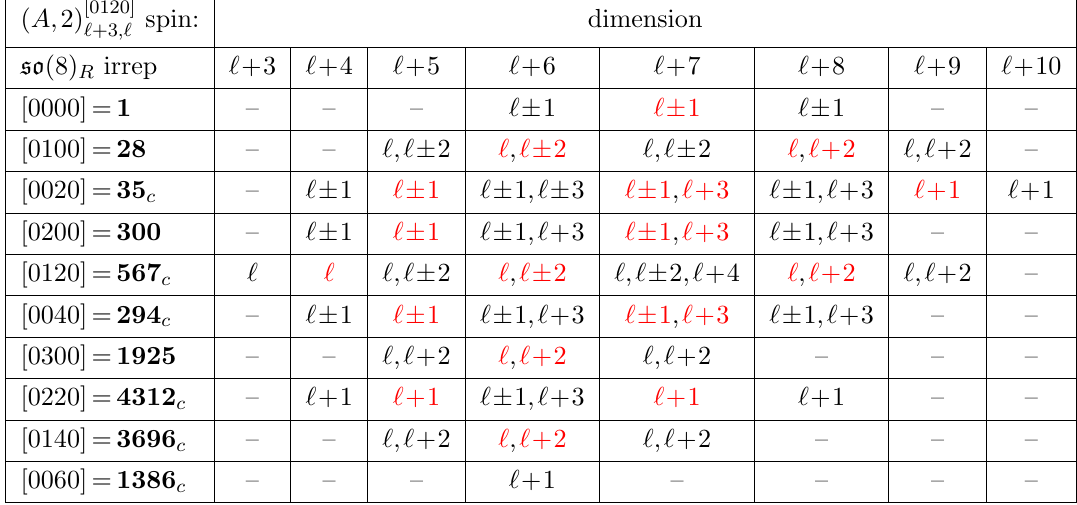
Table 27 . All possible conformal primaries in S 3 (cid:2) S 3 corresponding to the ( A; 2) [0120] formal multiplet.